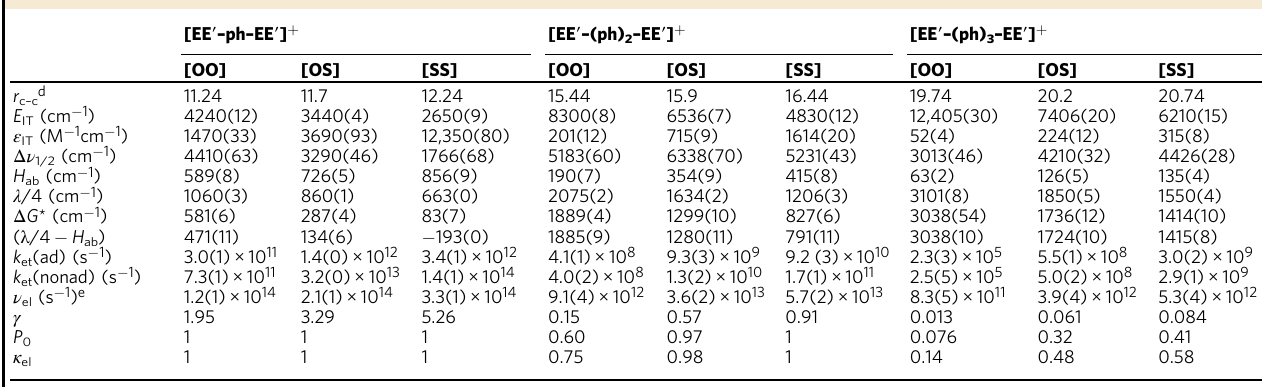
Table 1 Spectroscopic and ET kinetic data a and the LZ parameters b for mixed-valence complexes [EE ′ – (ph) n – EE ′ ] + (E E ′ = O or S and n = 1 – 3) c .